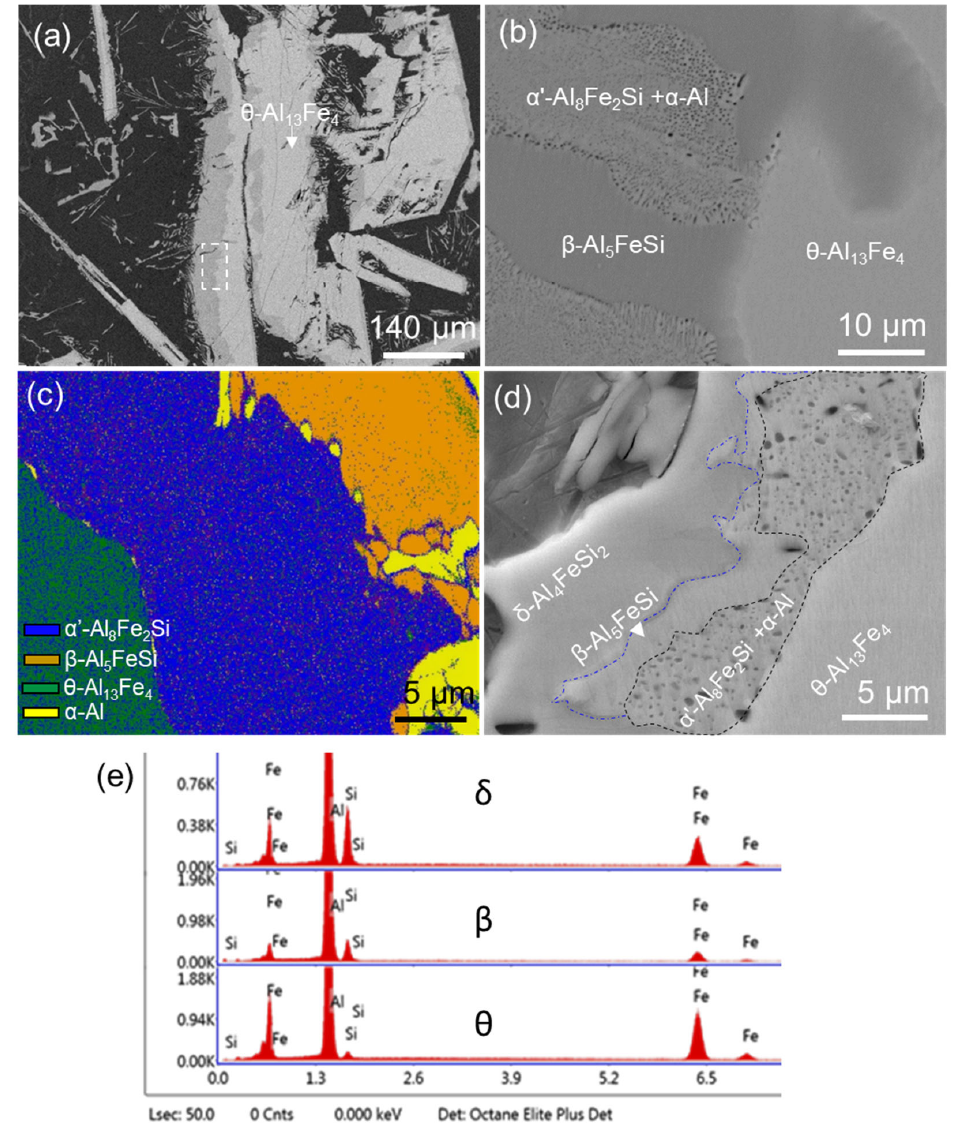
Figure 12. The multi ‐ step phase transformation from θ to α ’ ‐ Al 8 Fe 2 Si, β‐ Al 5 FeSi, then δ‐ Al 4 FeSi 2 observed with SEM ‐ BSE mode in Al ‐ 20Si ‐ 0.7Fe alloy, which solidified at 0.01 K/s. ( a ) SEM ‐ BSE image showing the elongated θ‐ Al 13 Fe 4 ; ( b ) the detailed microstructure in the area marked by the white frame in ( a ) showing a complex multi ‐ phase zone containing θ‐ Al 13 Fe 4 , α ’ ‐ Al 8 Fe 2 Si + α‐ Al and β‐ Al 5 FeSi phases; ( c ) a EBSD map for phase identification; and ( d ) δ‐ Al 4 FeSi 2 with a higher Si content was formed on the edge of FIMC particles after heat treatment at 530 °C for 30 min, and ( e ) the SEM ‐ EDS spectra of θ , β and δ shown in ( d ) [67].